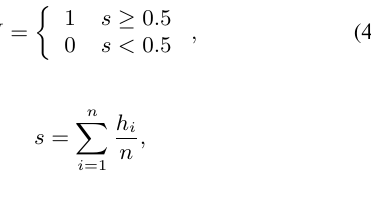
Figure 4. The flow of classification trees in ensemble